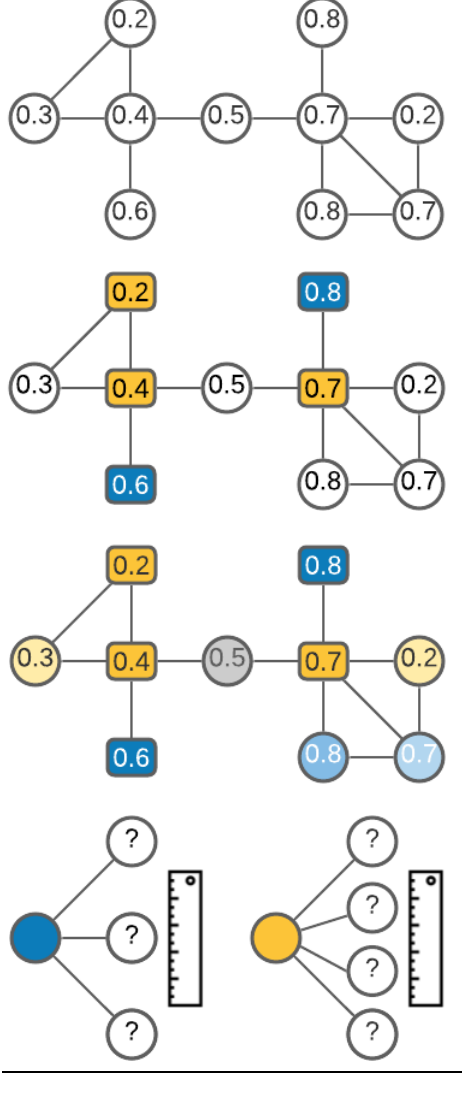
Figure 1: A summary of the homophily estimation process along a classified variable ( Y ; represented by color) with a known predictor ( X ; represented by a number), a subset of labeled nodes ( L ; represented by rectangles), and a known graph structure ( G